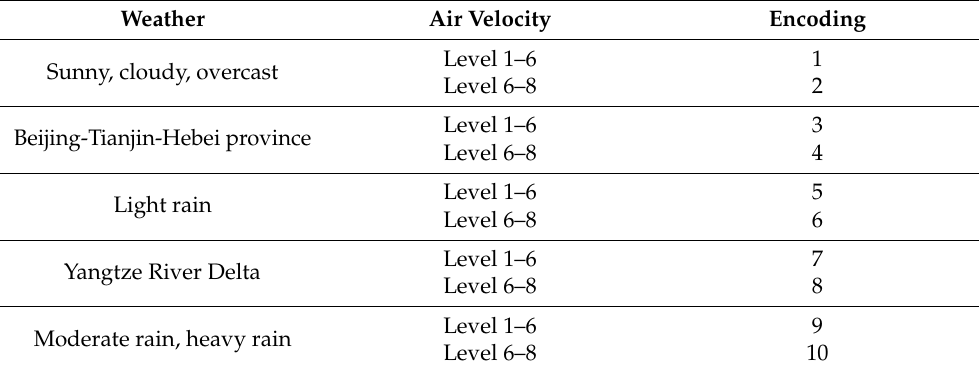
Table 3. Weather types after coding.